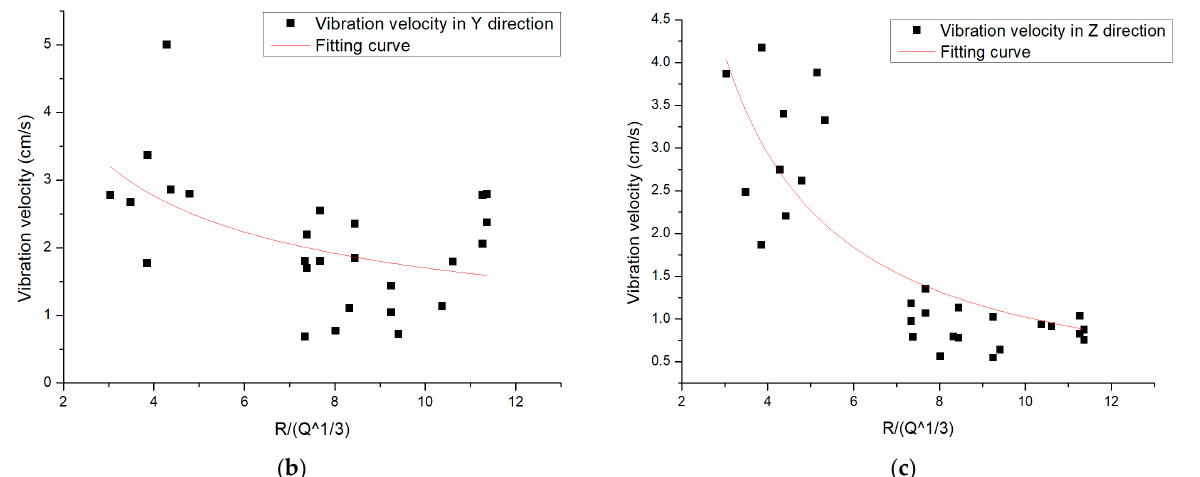
Figure 4. Vibration velocity in three directions of cutting hole blasting behind the working face: ( a ) X direction; ( b ) Y direction; ( c ) Z direction.